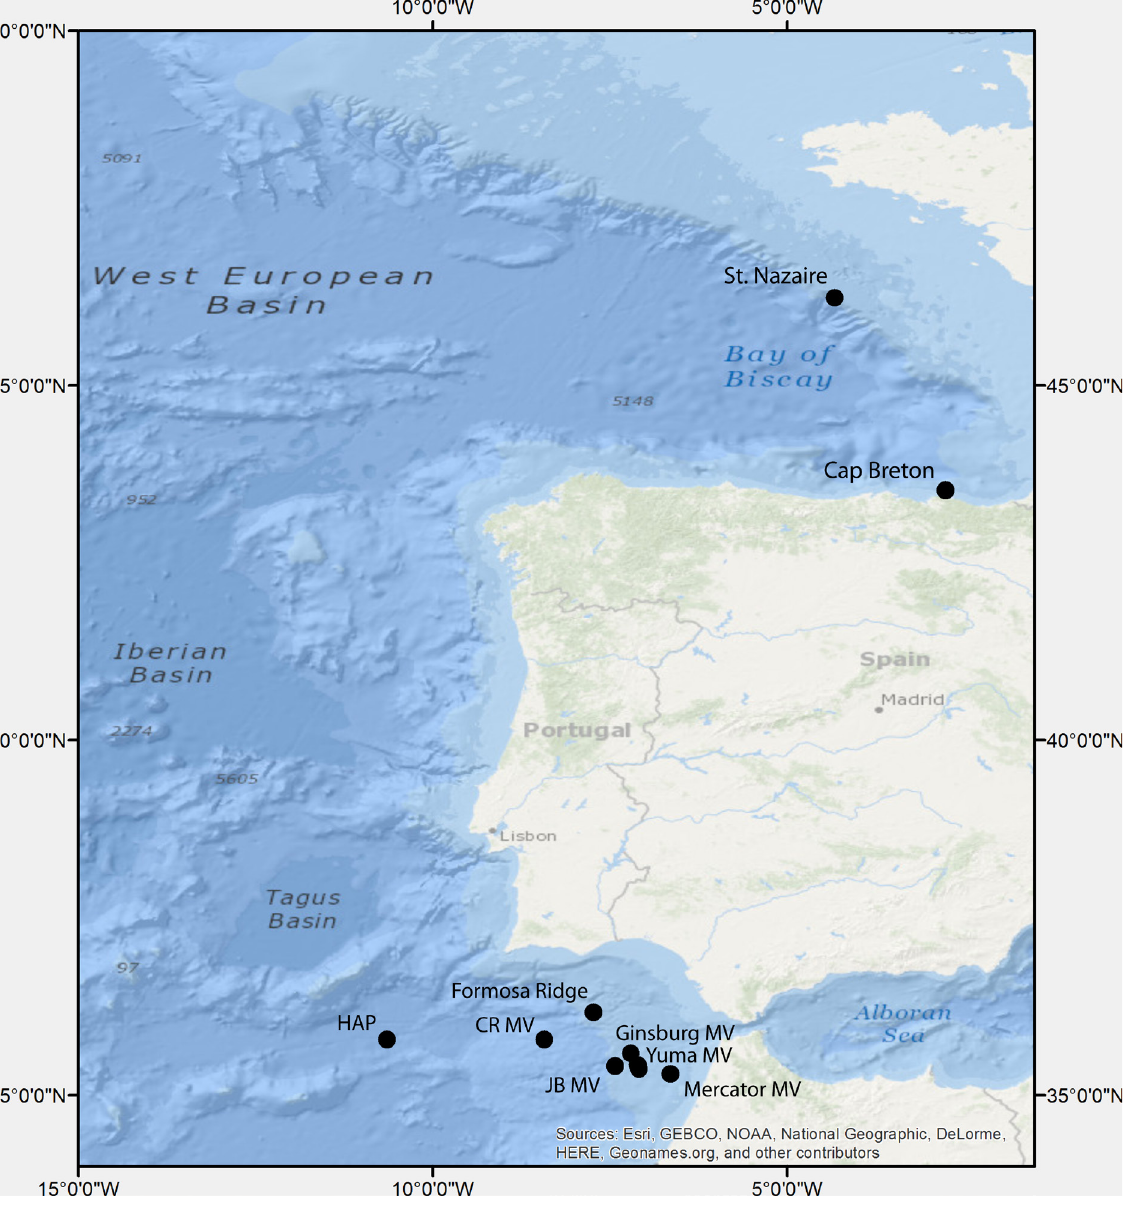
Fig. 1. Map with the locations of the sampling sites. CR = Carlos Ribeiro; HAP = Horseshoe Abyssal Plain; JB = Jezus Baraza; MV = mud